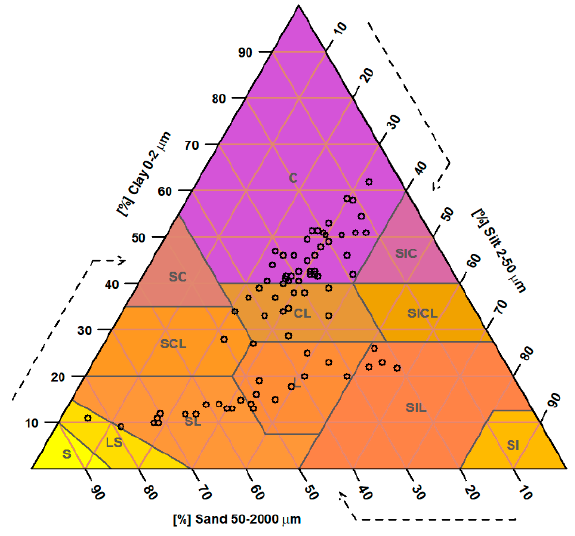
Figure 2. Soil texture of samples used in this study.